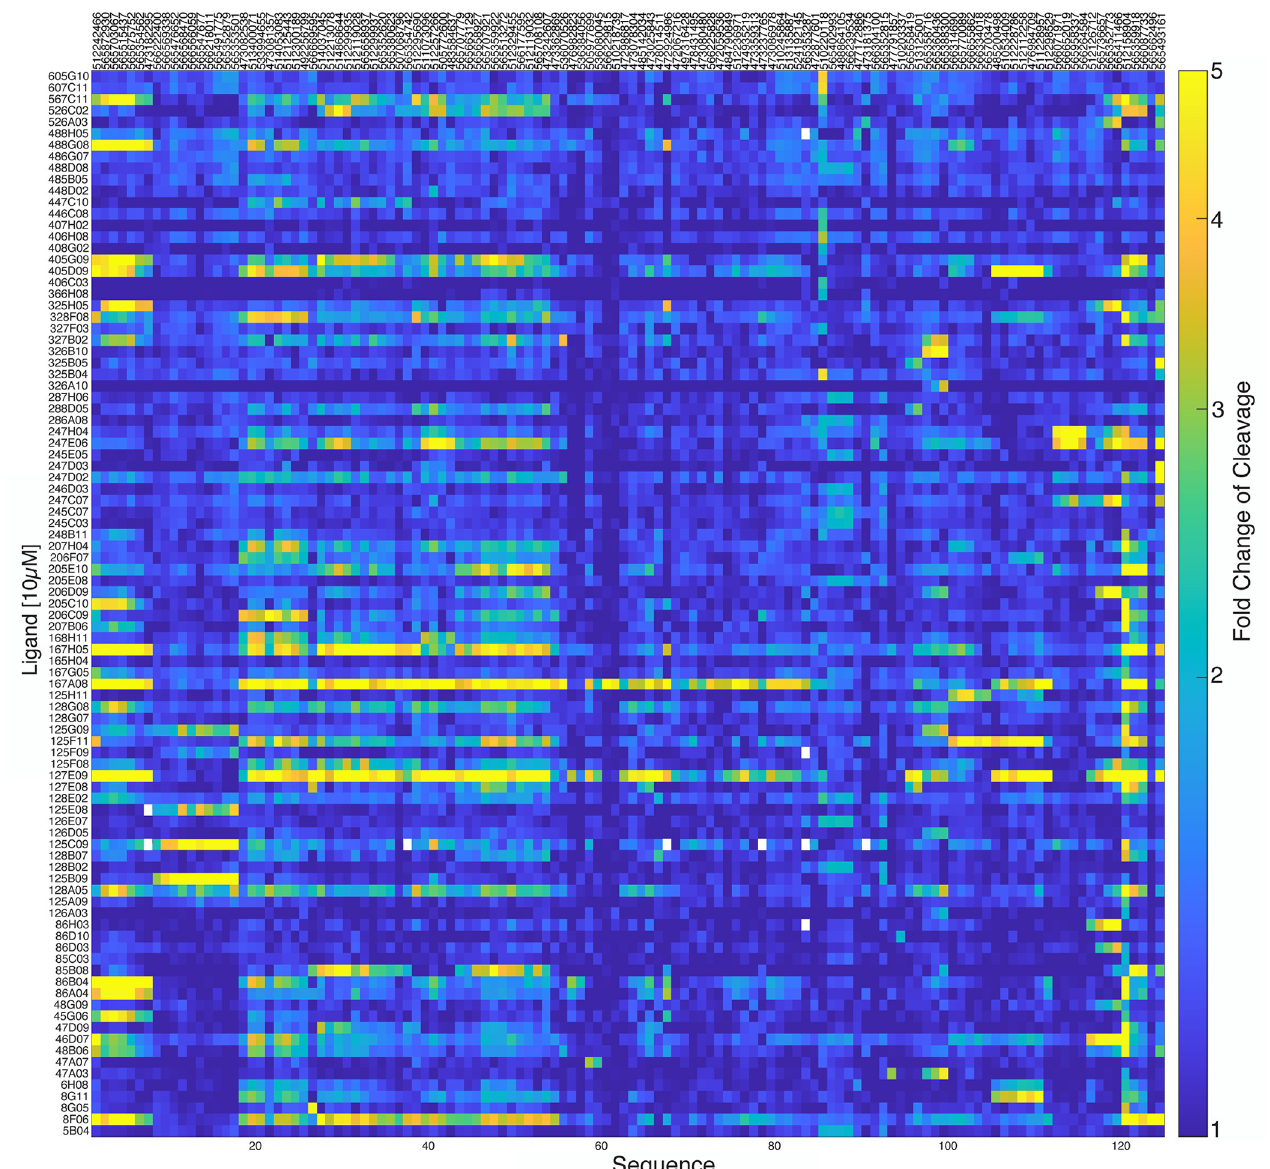
Fig 4. CleaveSeq results of biosensors against individual compounds shows patterns of promiscuous and selective biosensors. The pseudocolor plot shows the fold change of cleavage for sensors in the presence of single compounds at 10 μ M concentration. Sequences (after clustering as described in text) or compounds that result in at least 2-fold change in cleavage for at least one combination are